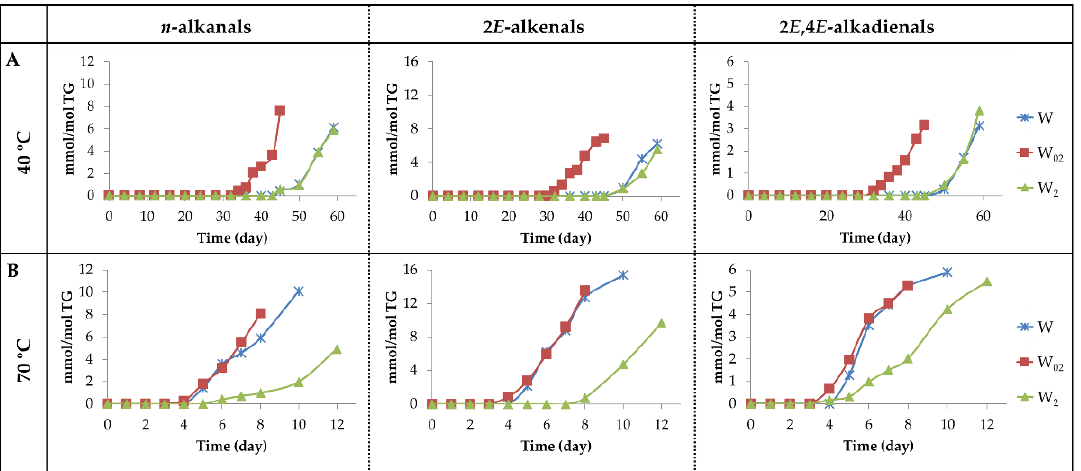
Figure 13. ( A ) Evolution of the concentration expressed as mmol/mol TG, of n -alkanals, 2 E -alkenals, and 2 E ,4 E -alkadienals in walnut oil with different enrichment levels of αT (W, W 02 and W 2 ) submitted to 40 °C up to advanced stages of the oxidation process; ( B ) the same at 70 °C.